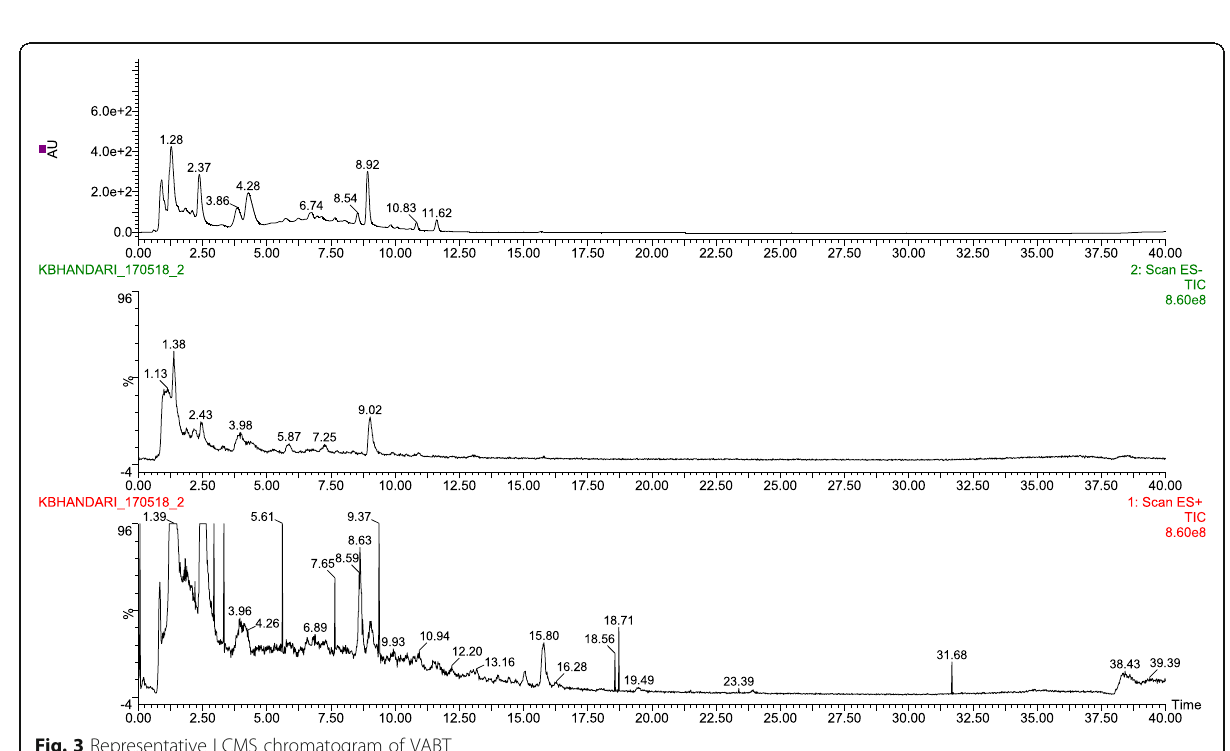
Fig. 3 Representative LCMS chromatogram of